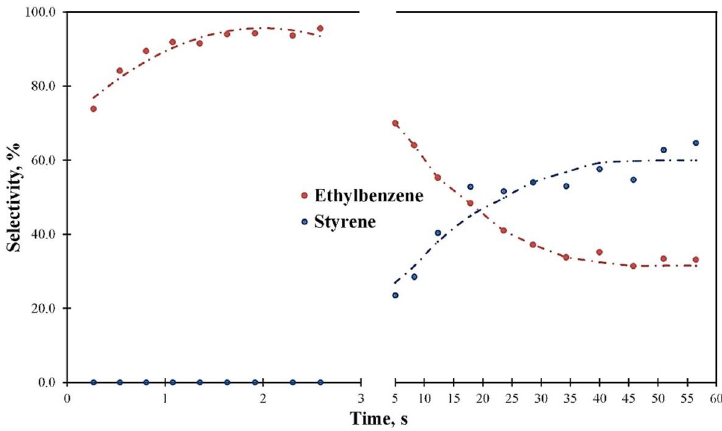
Figure 10. The main product selectivity vs. time on stream at 550 °C and WHSV 85 h − 1 for the 10% PS solution in HCO .